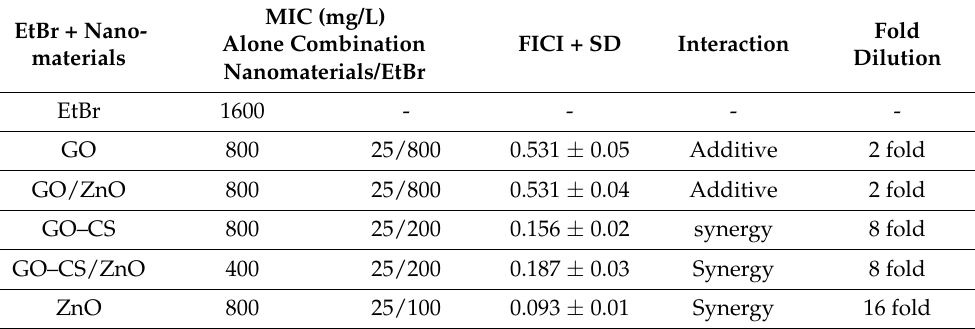
Table 2. Interaction study of nanomaterials (GO, GO/ZnO, GO–CS, GO–CS/ZnO, and ZnO) with ethidium bromide against PS-2.